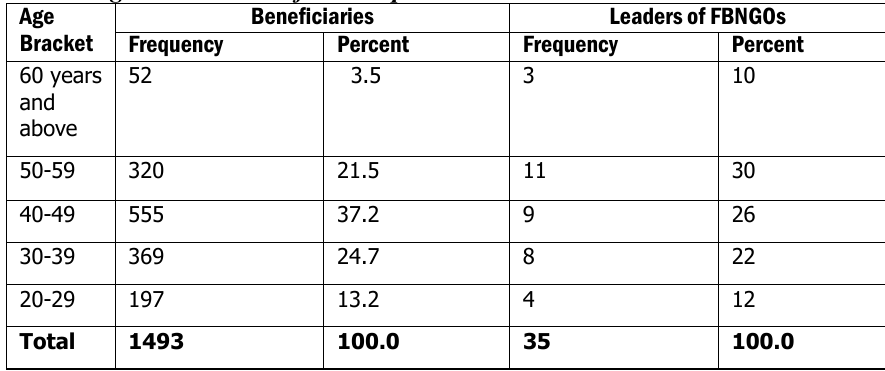
Table 1: Age Distribution of the